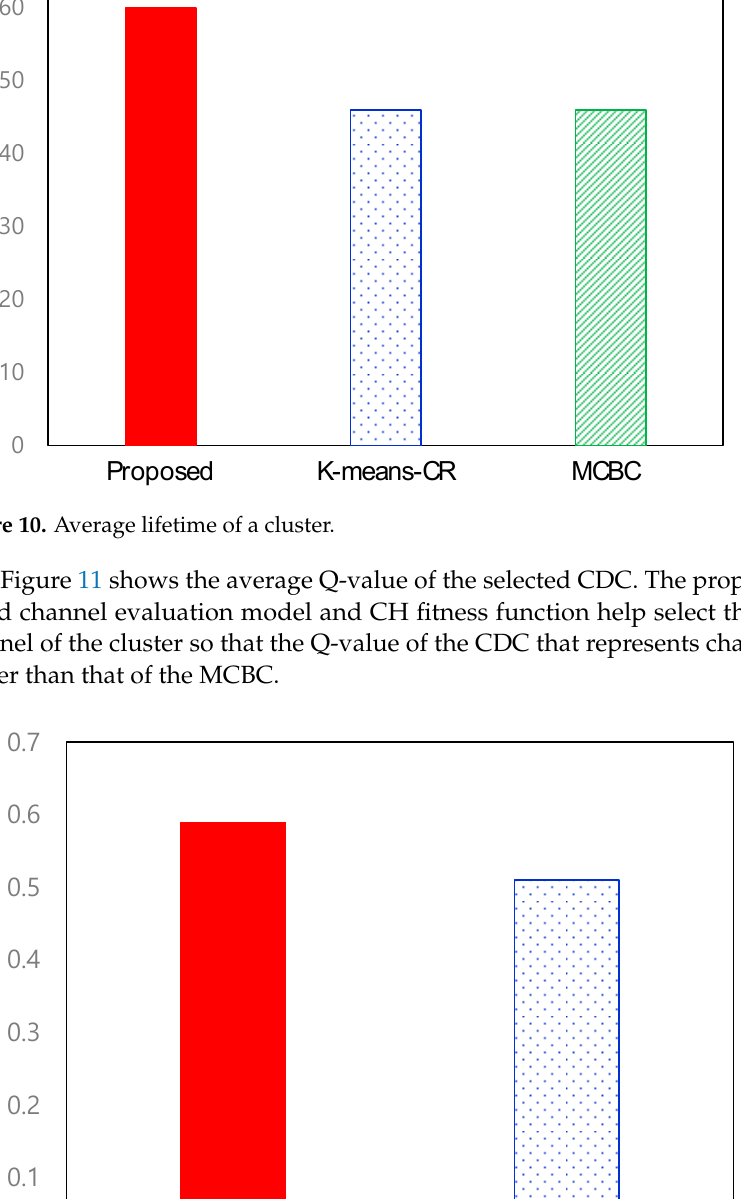
16 of 20 Figure 9. Utility cumulative distribution function.